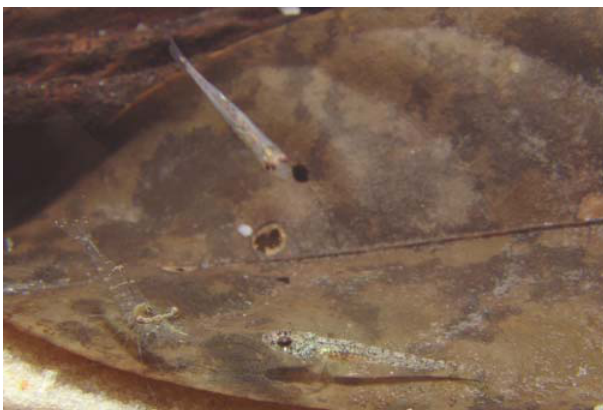
Fig. 2. Three members of the almost invisible league: Priocharax ariel (top centre), Palaemonetes carteri (bottom left), Microphilypnus amazonicus (bottom right) in aquarium under artificial light. Same specimens as in Fig. 1 except for M. amazonicus (17.8 mm SL, INPA 25244).